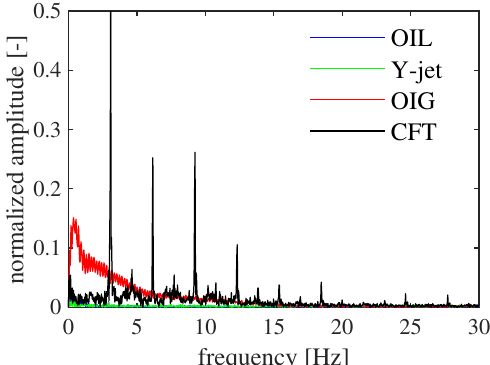
Figure 6. Power spectra of the D 32 t . d . at GLR = 2.5%, µ l = 60 mPa ·